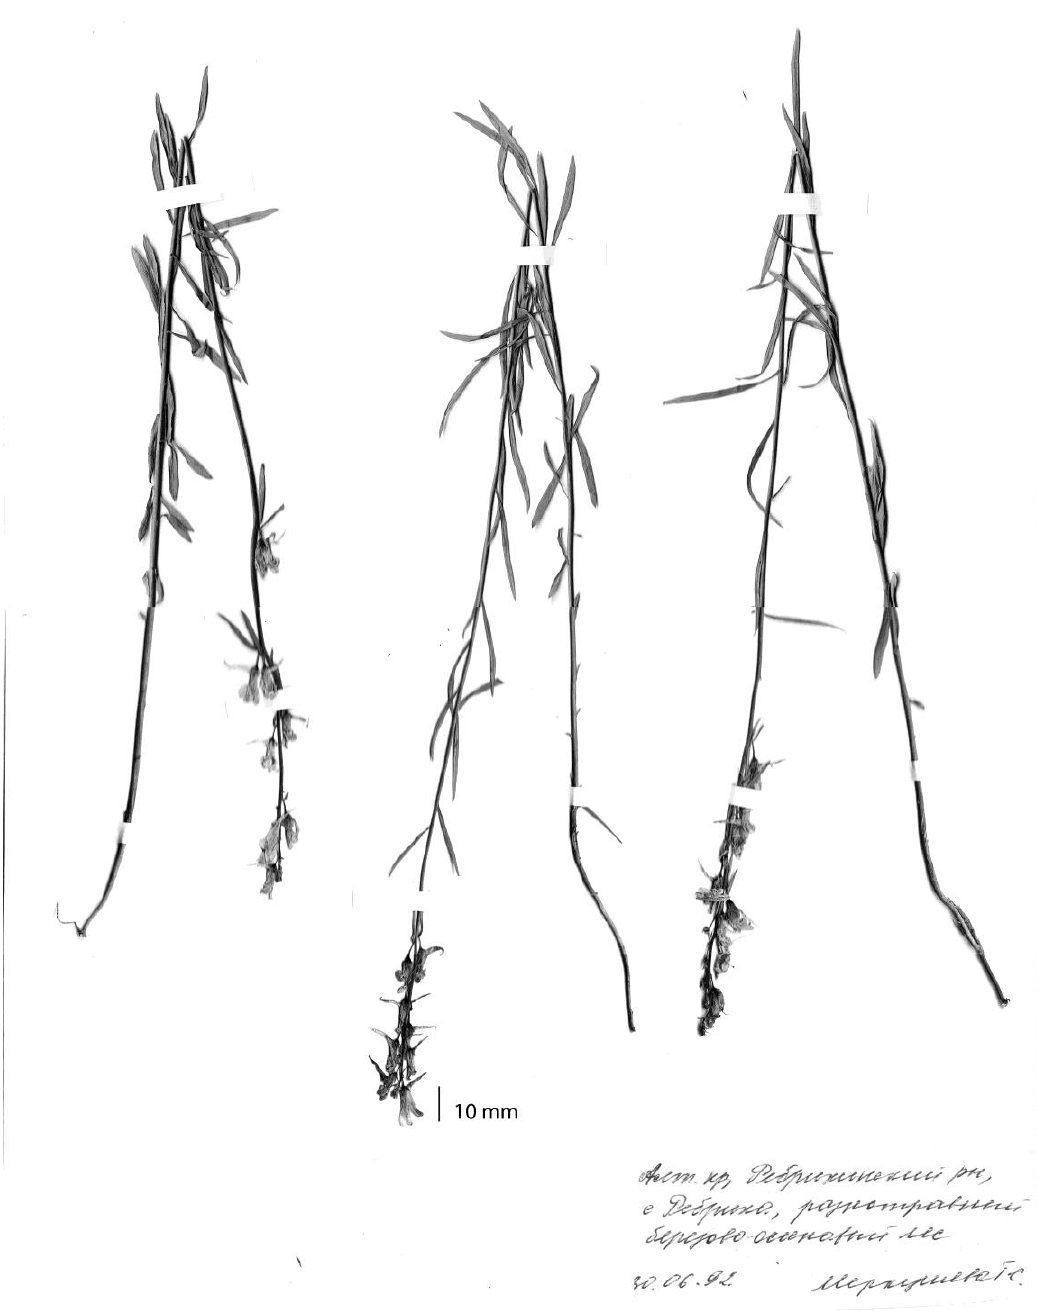
Рис. 1. Внешний вид Linaria vulgaris subsp. pinetorum Kosachev, subsp. nova.